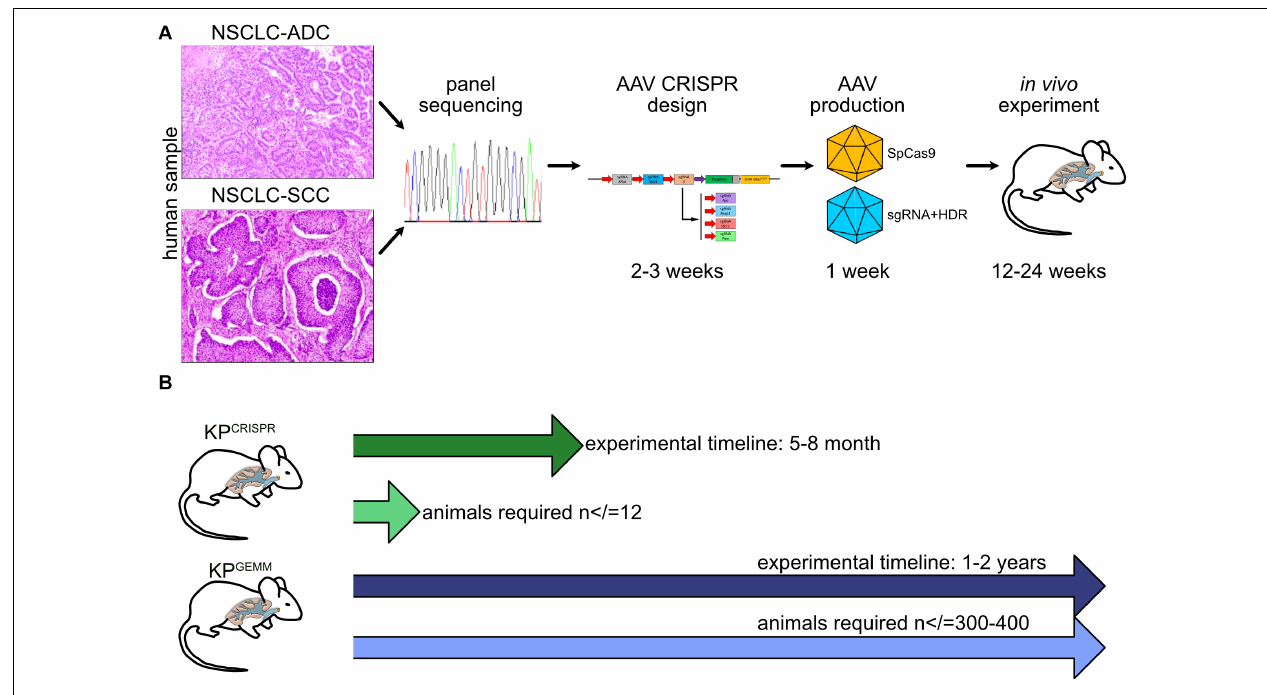
FIGURE 6 | Schematic model of CRISPR NSCLC models. (A) Workflow from “bed” to in vivo tumor model by CRISPR. (B) Comparison of time frame and animals used between KP GEMM and KP CRISPR